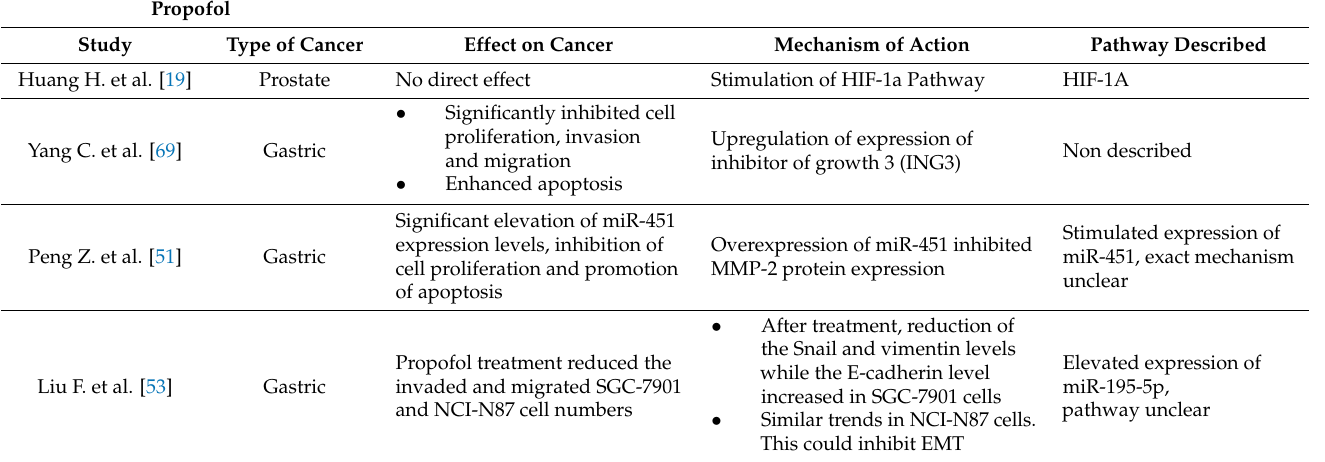
Table 3. Studies describing the direct effects of propofol on cancer cells, the associated mechanisms of action and their respective pathways 1